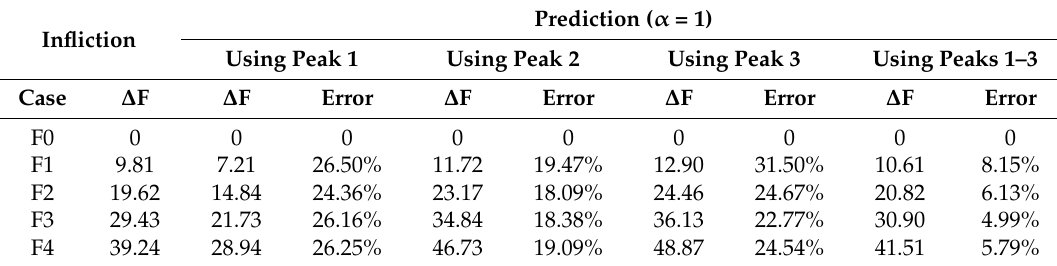
Table 6. Prediction of tension force changes (kN) in the finite element (FE) model of axial cylindrical member. Infliction Using Peak 1 Using Peak